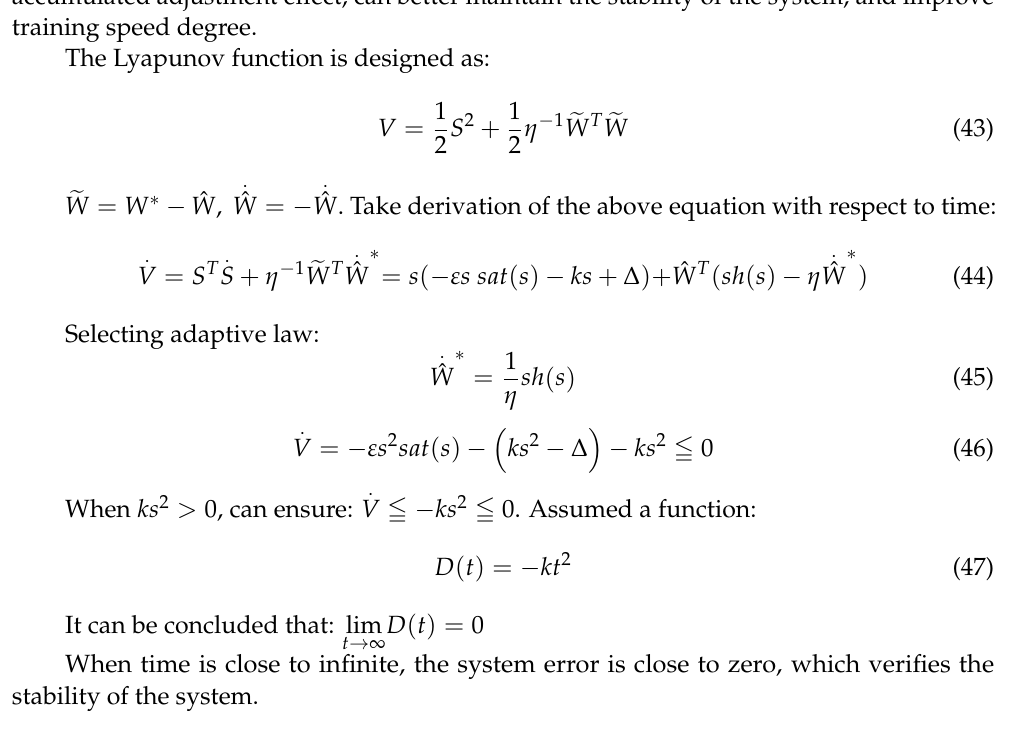
Figure 9. Configuration of experimental setup. 6. Simulation and Experiment Verification 6.1. Simulation Results In this section, the power simulation software is used to simulate control methods for surface permanent magnet synchronic motors. As can be seen, Figure 10 shows the simulation result of conventional sliding mode control, Figure 11 shows the simulation control of RBF neural network sliding mode con- trol, and Figure 12 shows the simulation results of adaptive RBF neural network sliding mode control, which includes rotor position waveform, speed waveform, three-phase cur- rent waveform, electromagnetic torque waveform, and the current waveform of the d and q axis. A load is added in 0.35 s in the simulation. Comparing the three groups of data, the conventional SMC can obtain the real-time performance the same as the other two groups, but the overshoot is higher than others. The overshoot after adding load inFigure 10 is 0.208V, in Figure 11, the overshoot value after adding load is down to 0.105V, this value in Figure 12 is down to 0.002V. The wave range of conventional sliding mode control